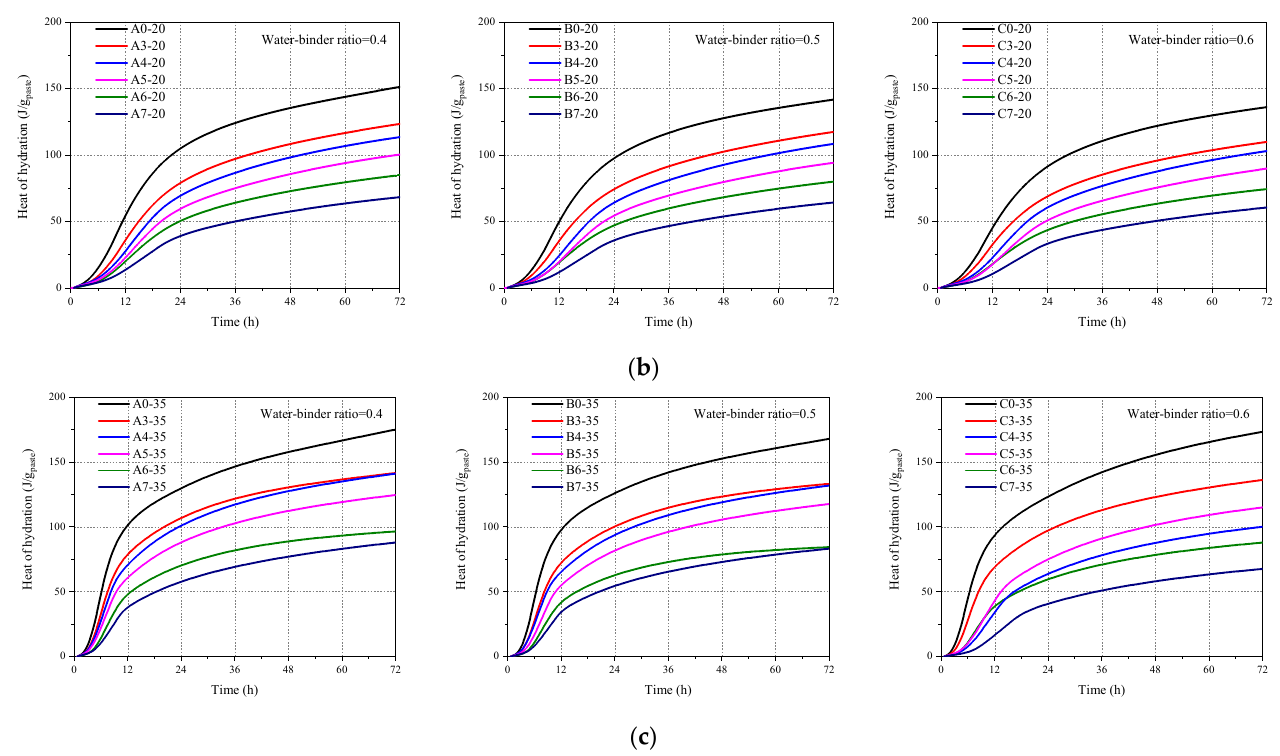
Figure 4. Cumulative heat release of cement pastes at different temperatures. ( a ) cumulative heat release of the cement paste at 10 °C; ( b ) cumulative heat release of cement paste at 20 °C; ( c ) cumulative heat release of cement paste at 35 °C.